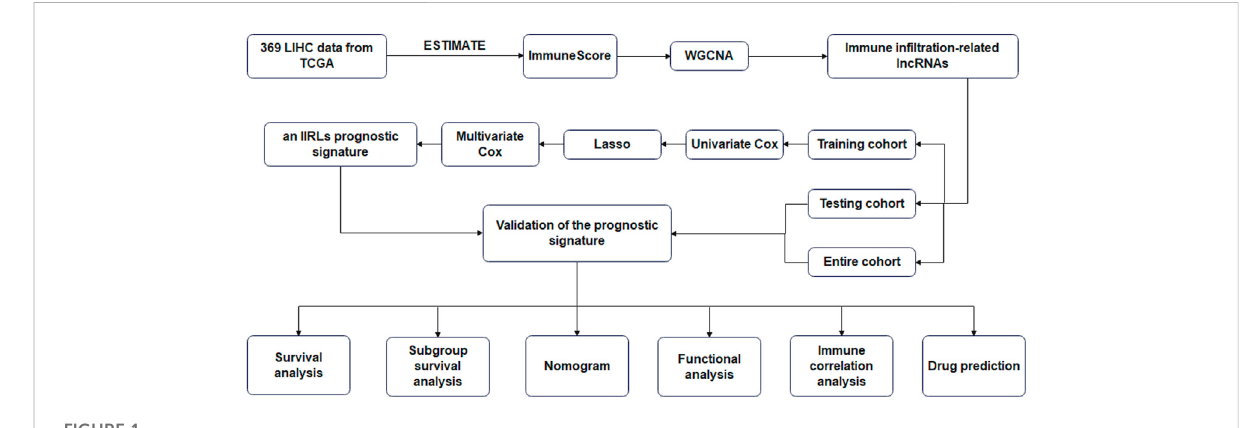
FIGURE 1 The fl ow chart of this study.